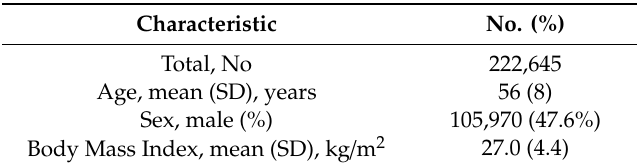
Table 1. Baseline